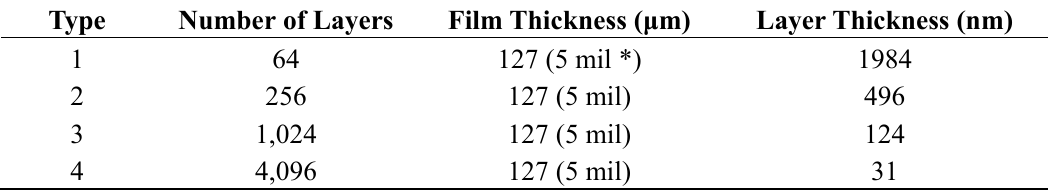
Figure 1. The sample of the multilayered film. Table 1. Films with various layer thicknesses.